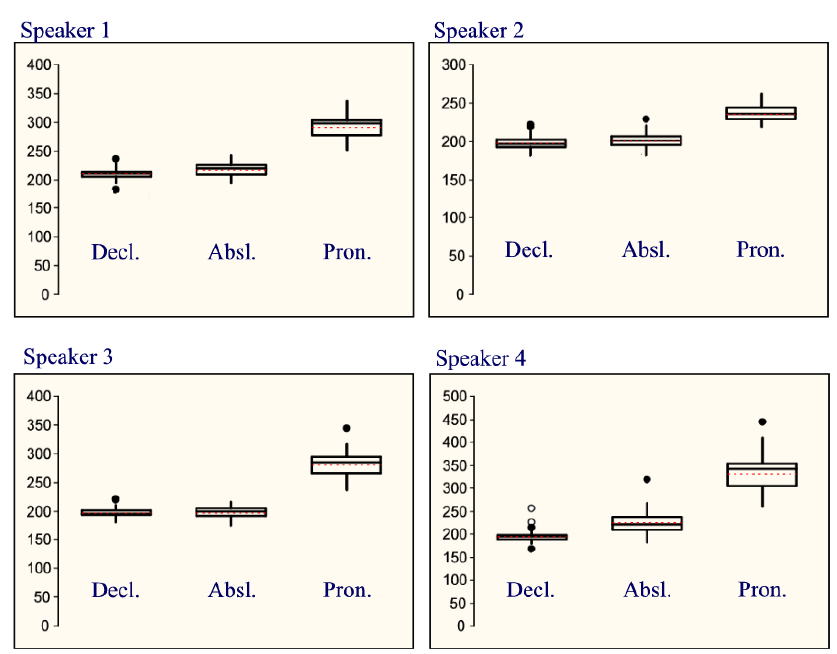
Figure 3. Box plots of initial tonal values for all speakers. Tonal values are based on raw Hz